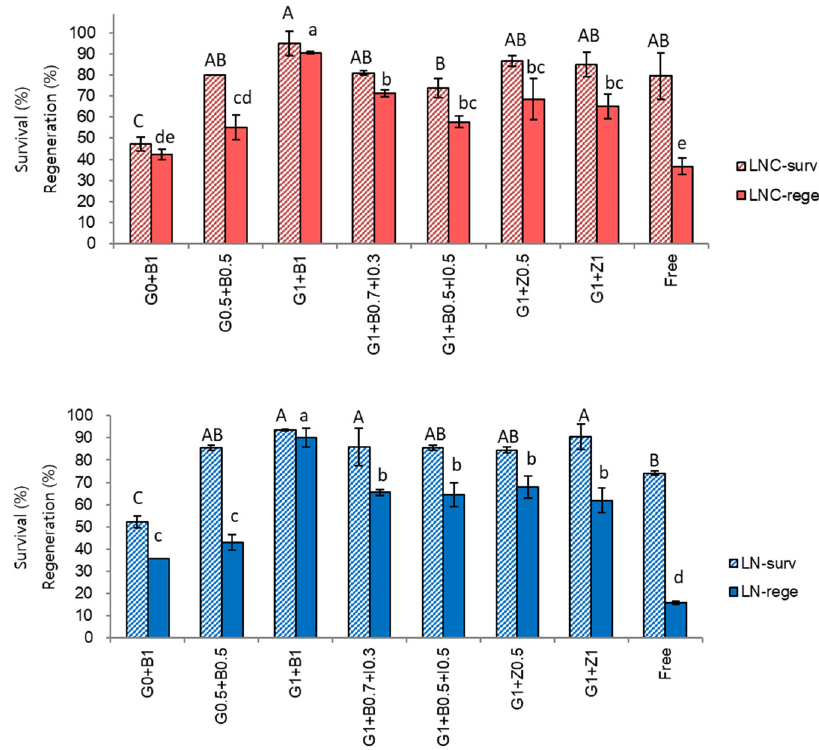
Figure 4. Effect of growth regulators in regrowth medium (steps 1 and 2 of the three-step regrowth procedure) on survival (surv) and regeneration (rege) of cryoprotected (LNC) and cryopreserved (LN) Pogostemon yatabeanus shoot tips in the droplet-vitrification procedure. G0, G1-0 and 1 mg/L gibberellic acid-3; B0, B0.5, B0.7 and B1-0, 0.5, 0.7 and 1 mg/L benzyl adenine; Z1-1 mg/L zeatin; I0.3 and I0.5-0.3 and 0.5 mg/L indolyl acetic acid; Free—medium without growth regulators.